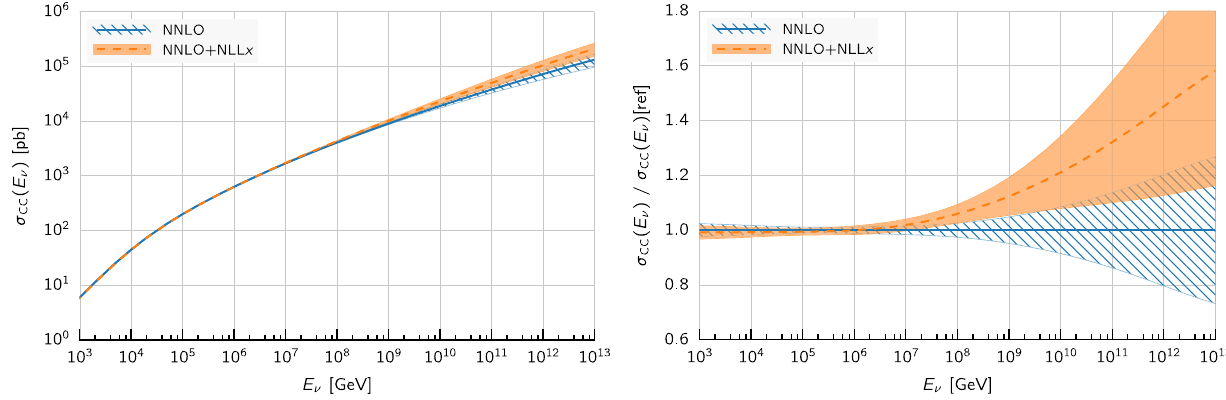
Fig. 33 The UHE neutrino–nucleus charged-current cross-section σ CC ( E ν ) as a function of the neutrino energy E ν , comparing the results obtained using the NNPDF3.1sx NNLO fits with those of the its resummed NNLO+NLL x